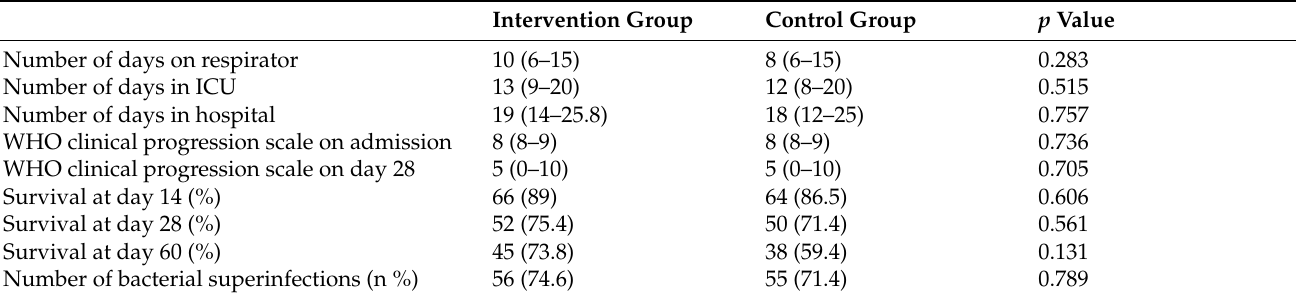
Table 2. Outcomes of intervention and control group.